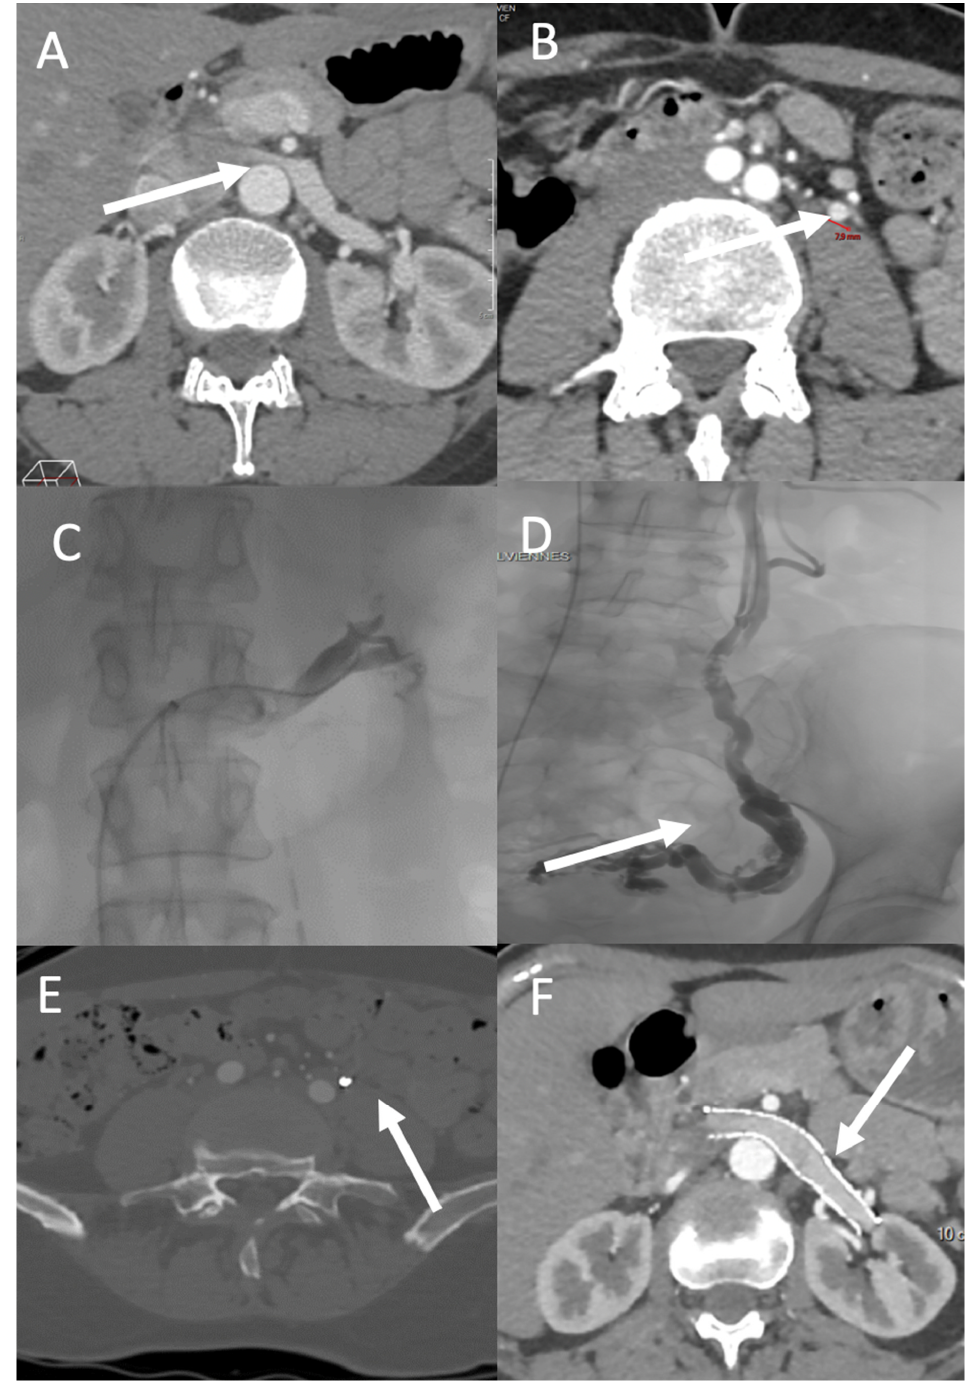
Figure 3. PVD affecting zones 1 and 2. A 49-year-old-woman with left flank pain (VAS pain score = 7), hematuria, and left chronic pelvic pain exacerbated by prolonged standing (VAS pain score = 5). ( A ) CT shows compression of the left renal vein over the abdominal aorta (arrow) and ( B ) a dilated left ovarian vein (diameter = 8 mm; arrow). Venography demonstrates attenuation over the abdominal aorta with a venous pressure gradient of 6 between the vena cava and left renal vein ( C ), and an incompetent left ovarian vein feeding a pelvic varicose vein (arrow) ( D ). Three months after treatment, CT shows successful embolization (using Onyx) of the left ovarian vein (( E ), arrow) and patency of the left ovarian vein stent (( F ), arrow). The left flank and chronic pelvic VAS pain scores decreased to 3 and 1,